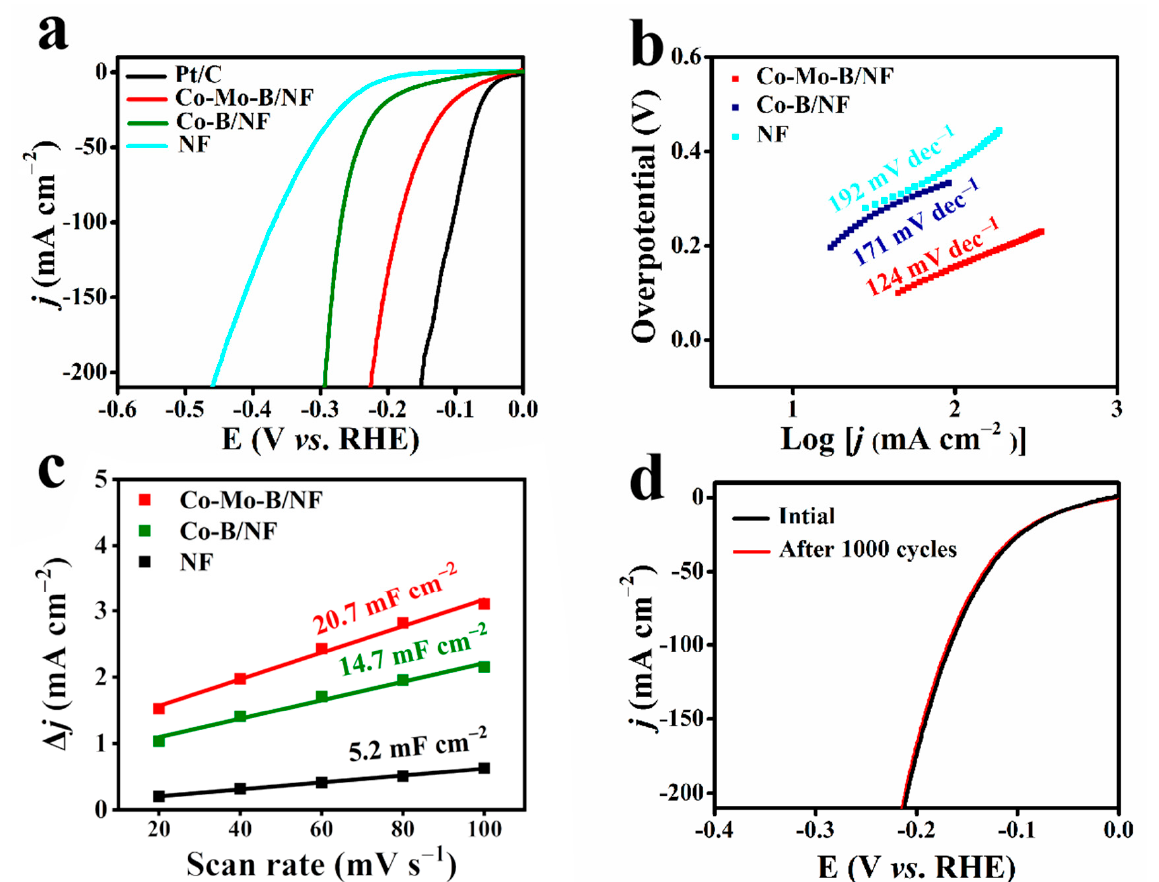
Figure 3. ( a ) Polarization curves, ( b ) Tafel plots for different materials in 1 M KOH. ( c ) Corresponding electrochemical double layer capacitances of Co-Mo-B/NF, Co-B/NF, and bare NF. ( d ) Polarization curves for Co-Mo-B/NF before and after 1000 CV cycles in 1 M KOH.